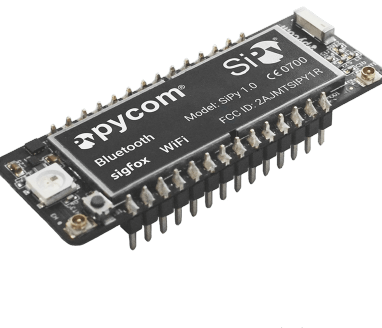
Figure 16. Pycom module.